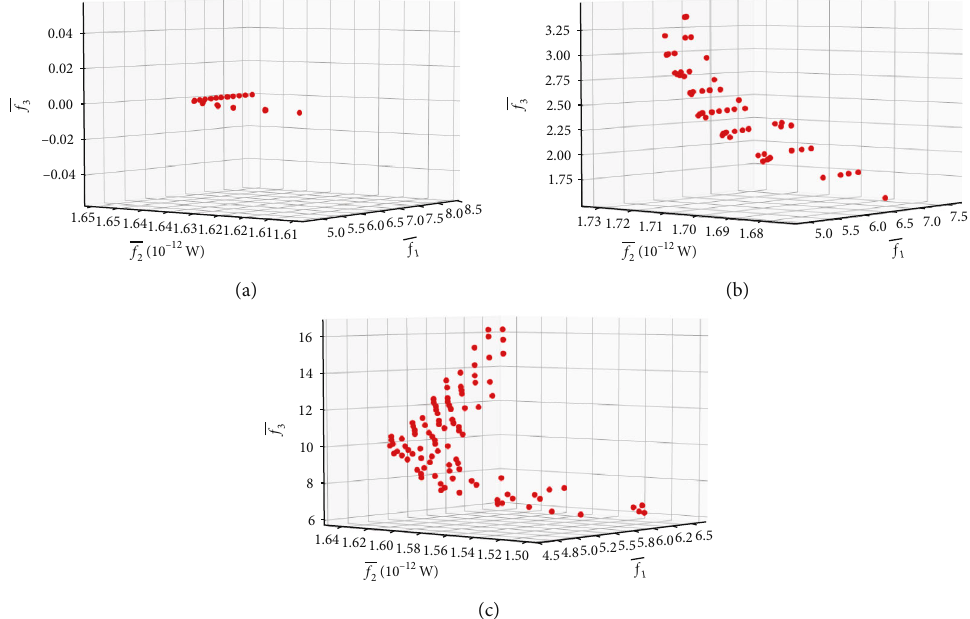
Figure 6: The Pareto front with di ff erent density levels of users: (a) Scenario 1 (sparse); (b)Scenario 2 (general); (c) Scenario 3 (dense).